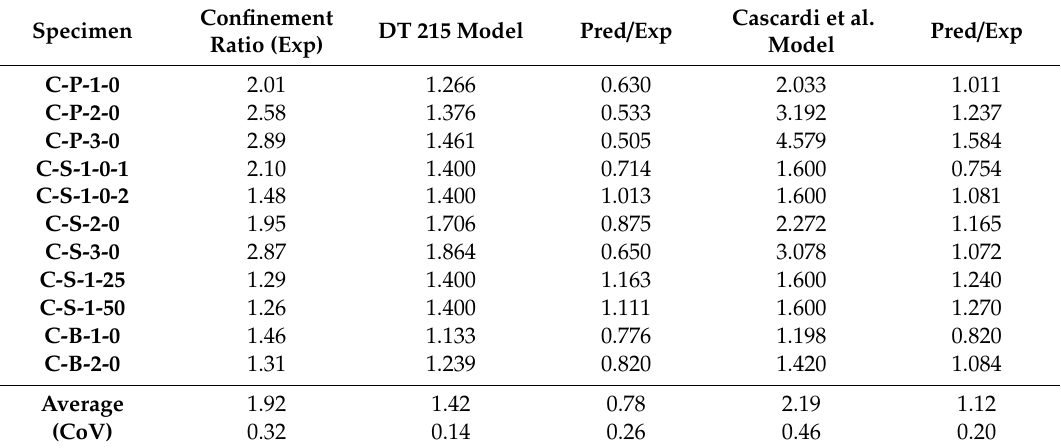
Table 6. Model predictions / experimental